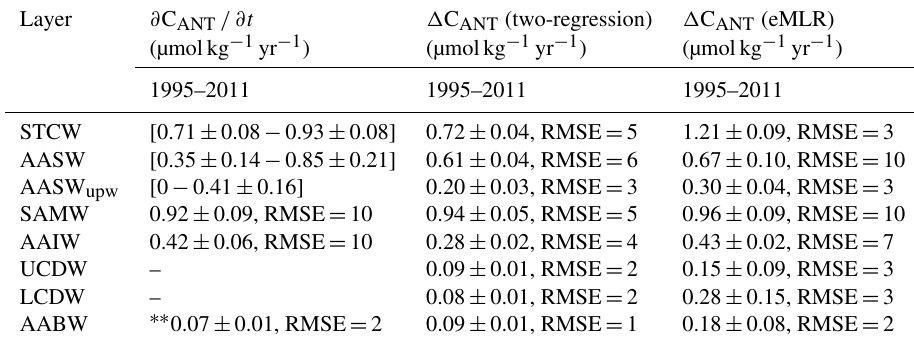
Table 7. Comparison between ∂ C ANT from the present study and the values of (cid:49) C ANT from the two-regression and eMLR methods. ∂t RMSE = root mean square error. ∗∗ The value of ∂ C ANT in the AABW layer is considered negligible because it falls below the accuracy of ∂t the back-calculation